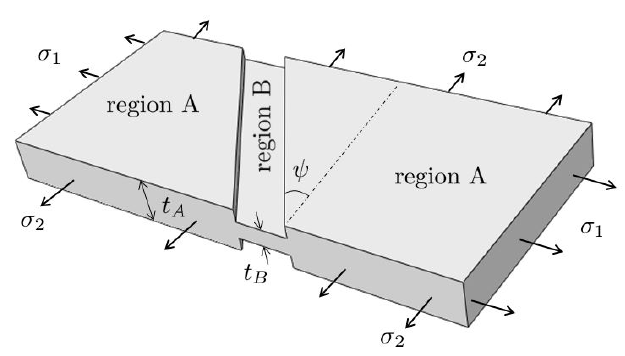
Figure 1. Modified MK model with initial in-homogeneity